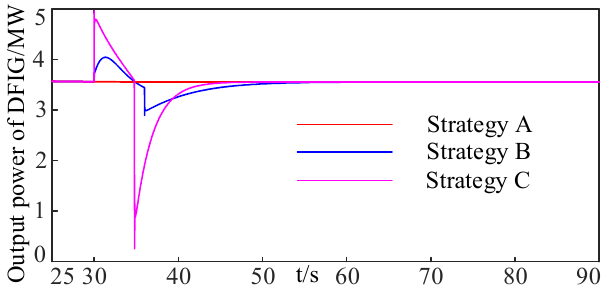
Figure 10. Output active power of DFIG under different control strategies.